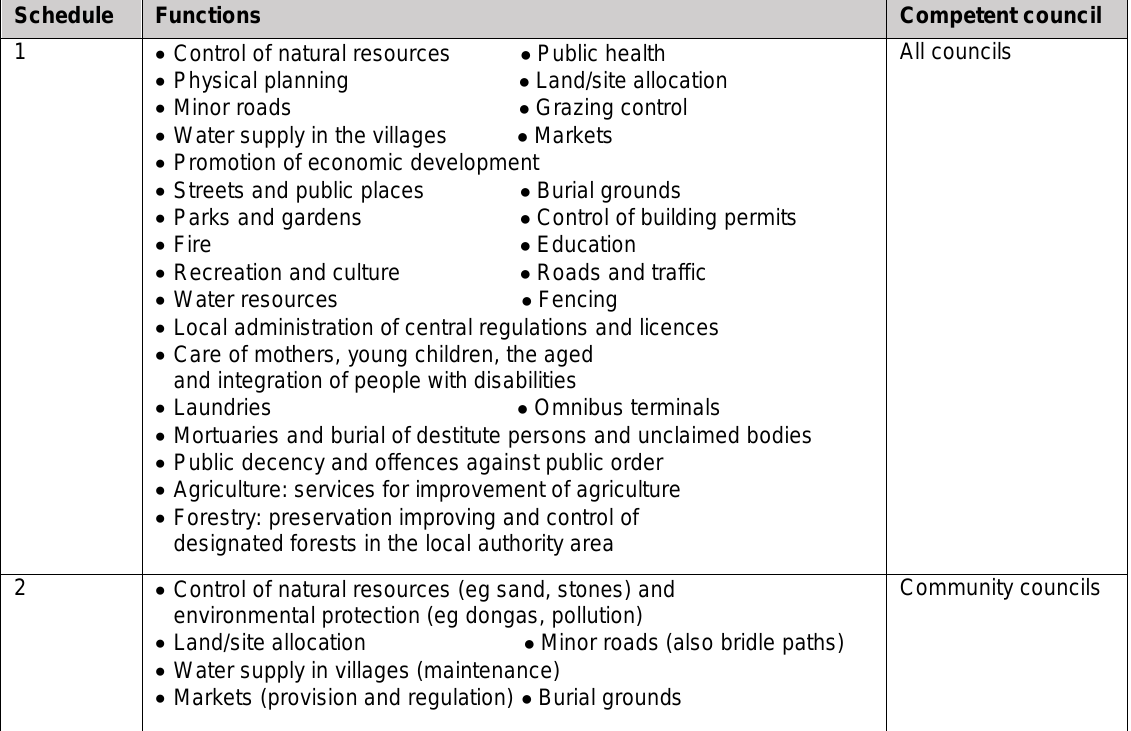
Table 5: Assignment of functions to local authorities, section 5 of the Local Government Act